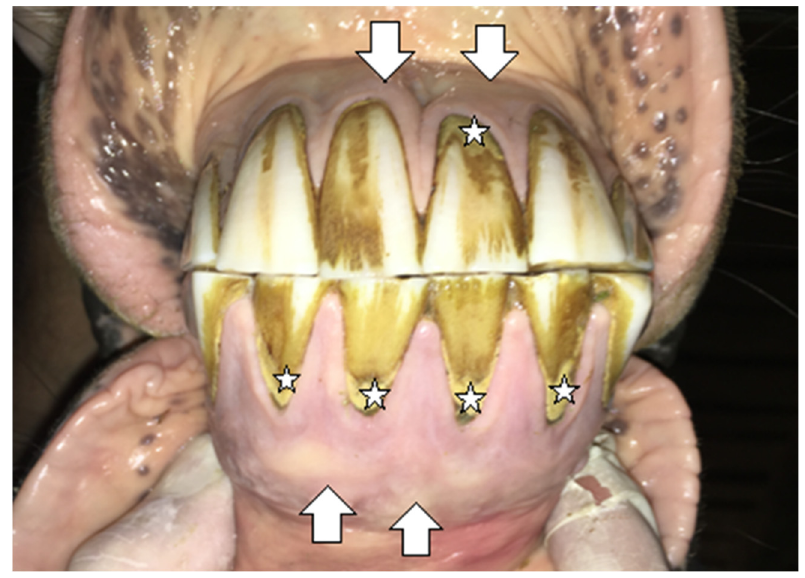
Figure 2. Case 1—the condition of the maxillary and mandibular incisors before extraction. Defor ‐ mation of the incisal area (white arrows). Excessive calculus deposition (white stars).